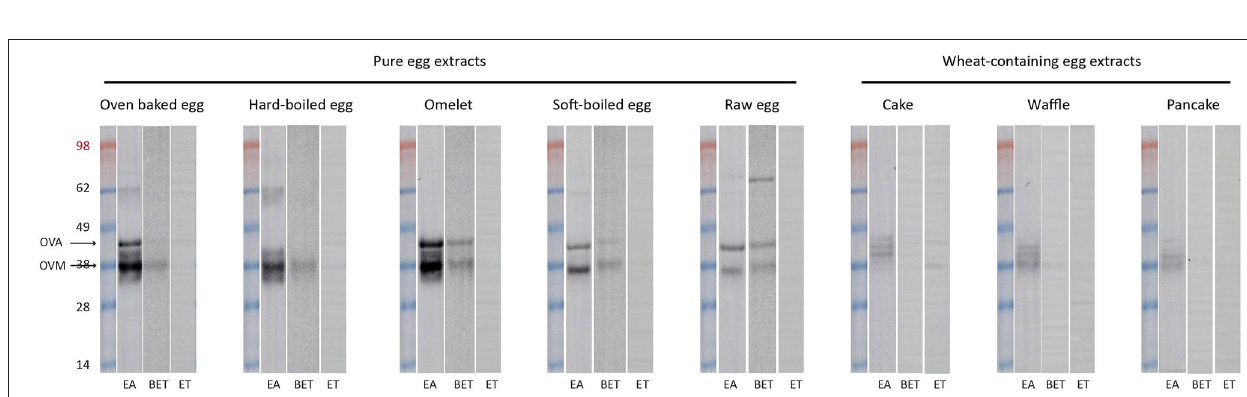
FIGURE 2 | (A) SDS-PAGE analysis of the five pure egg extracts followed by silver staining. MW, SeeBlue TM Pre-stained Protein Standard (Thermofisher, LC5625), BE, oven baked egg; HE, hard-boiled egg; OM, omelet; SE, soft-boiled egg; RE, raw egg; ovalbumin (OVA) grade VII (Sigma), OVA grade V (Sigma), ovomucoid (OVM) type III free of ovo-inhibitor (Sigma). (B) SDS-PAGE pattern of the pure egg extracts of oven baked egg and omelet and their corresponding processed extracts of cake and waffles/pancakes, respectively. CK, cake; WF, waffles; PC, pancakes.